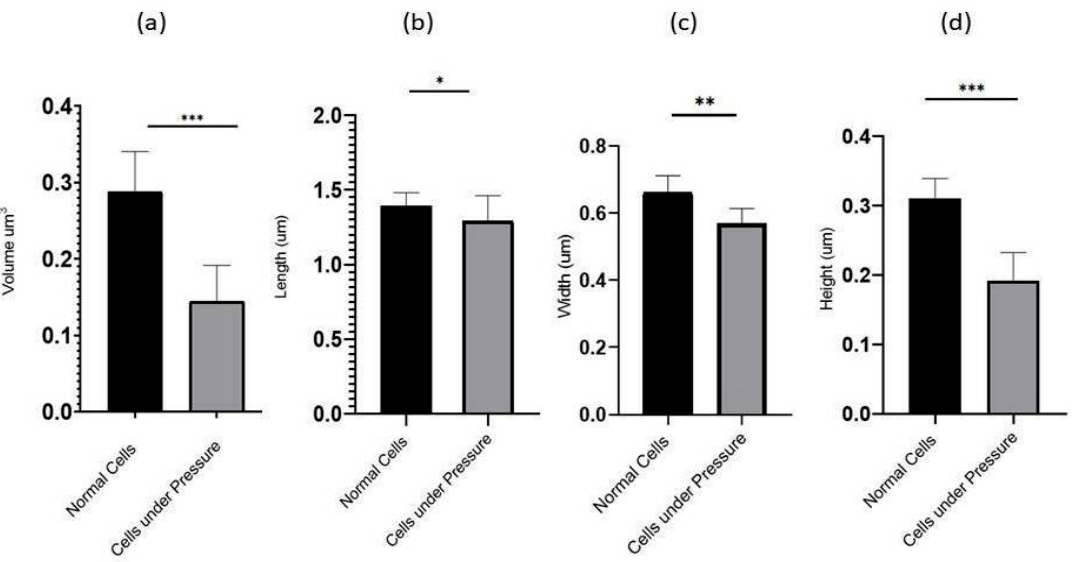
Figure 5. The graph depicted the compression of Volume ( a ) and physical dimensions: length ( b ), Width ( c ), and Height ( d ) between 35 randomly selected cells under the stress of weight (15.45 g) and normal cells. The comparative analysis indicated that the cells under weight were reduced in volume. Conversely, cells occupying the lower base of biofilm consortia without weight pressure (normal cells) maintained the normal physiology of P. aeruginosa . All parameters were measured from SEM and AFM images using Gwyddion 2.60. All values are statistically significant, *, **, *** represent p values <0.002, p < 0.001 and p < 0.0001, respectively.